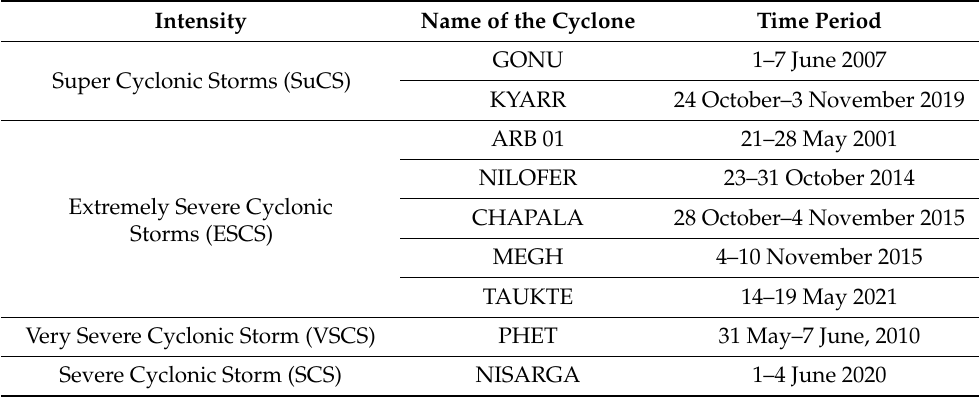
Table 1. Summary of cyclonic storms witnessed over Arabian Sea region.